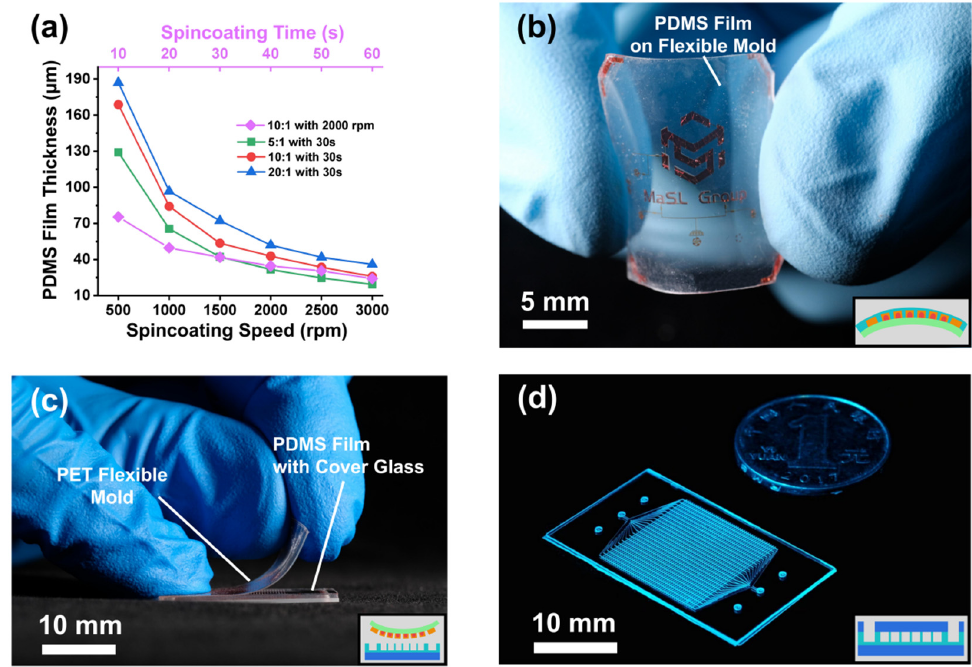
Figure 5. Fabrication results of G-P-G MFD: ( a ) data of the PDMS thickness under different spin- coating parameters and PDMS mixture ratios. ( b ) Flexible patterned mold with the PDMS film. ( c ) Process of PET flexible mold peeling off from the PDMS film with a glass cover. ( d ) G-P-G MFD with a total thickness of 200 μ m.